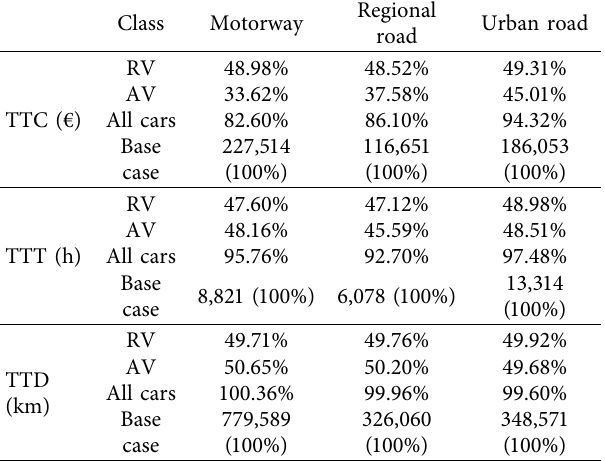
Table 4: Distribution of network performance indicators on dif- ferent road types for 50% MPR (indexing is based on the values of the base case